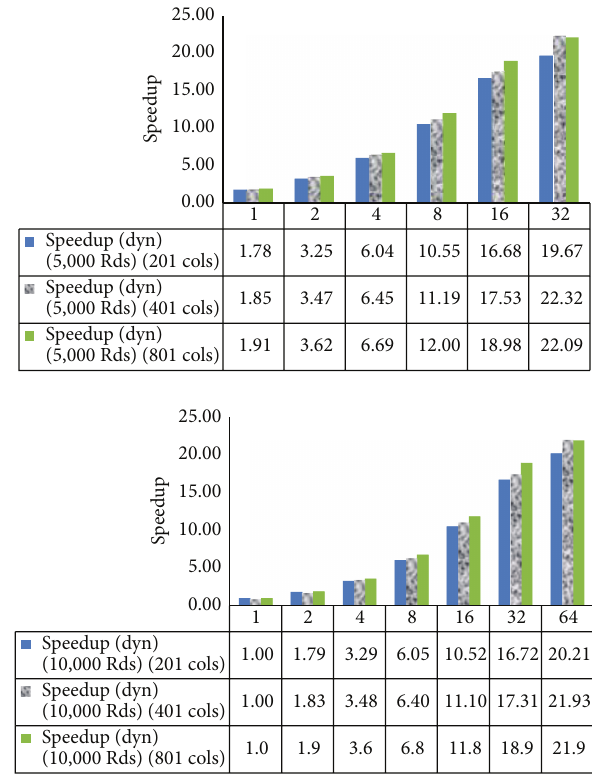
Figure 9: The speedup for 5,000 and 10,000 iterations, dynamic schedule varying number of